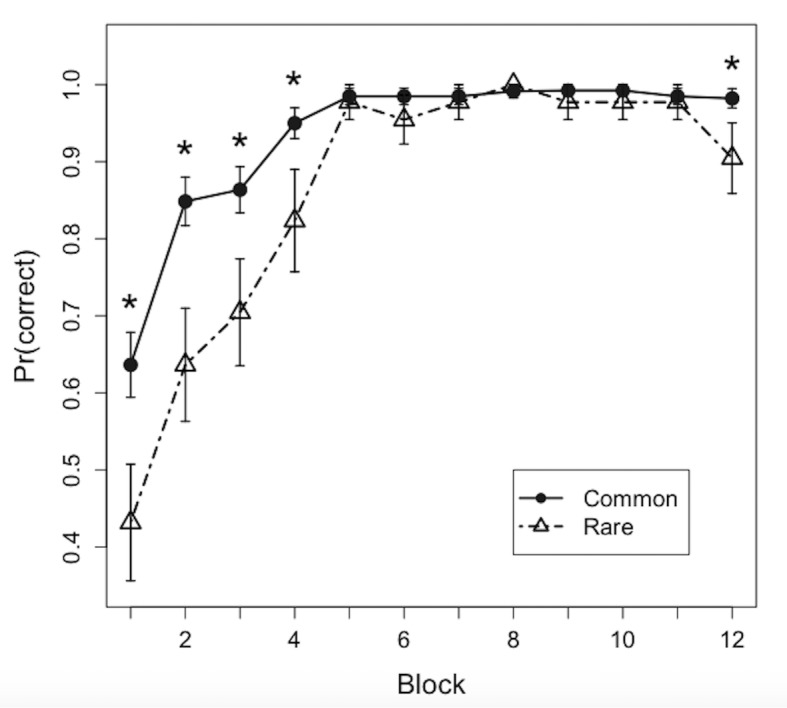
Learning curves.Points depict proportions correct for common and rare disease predictions over the 12 blocks of the training phase (mean ± SEM). *p < 0.05.